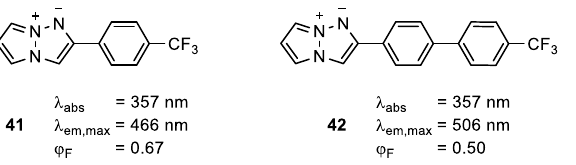
Figure 3. Structure and properties of 2-(4-(trifluoromethyl)phenyl)-TAP 41 and 2-(4’-(trifluorome- thyl)-[1,1’-biphenyl]-4-yl)-TAP 42 in